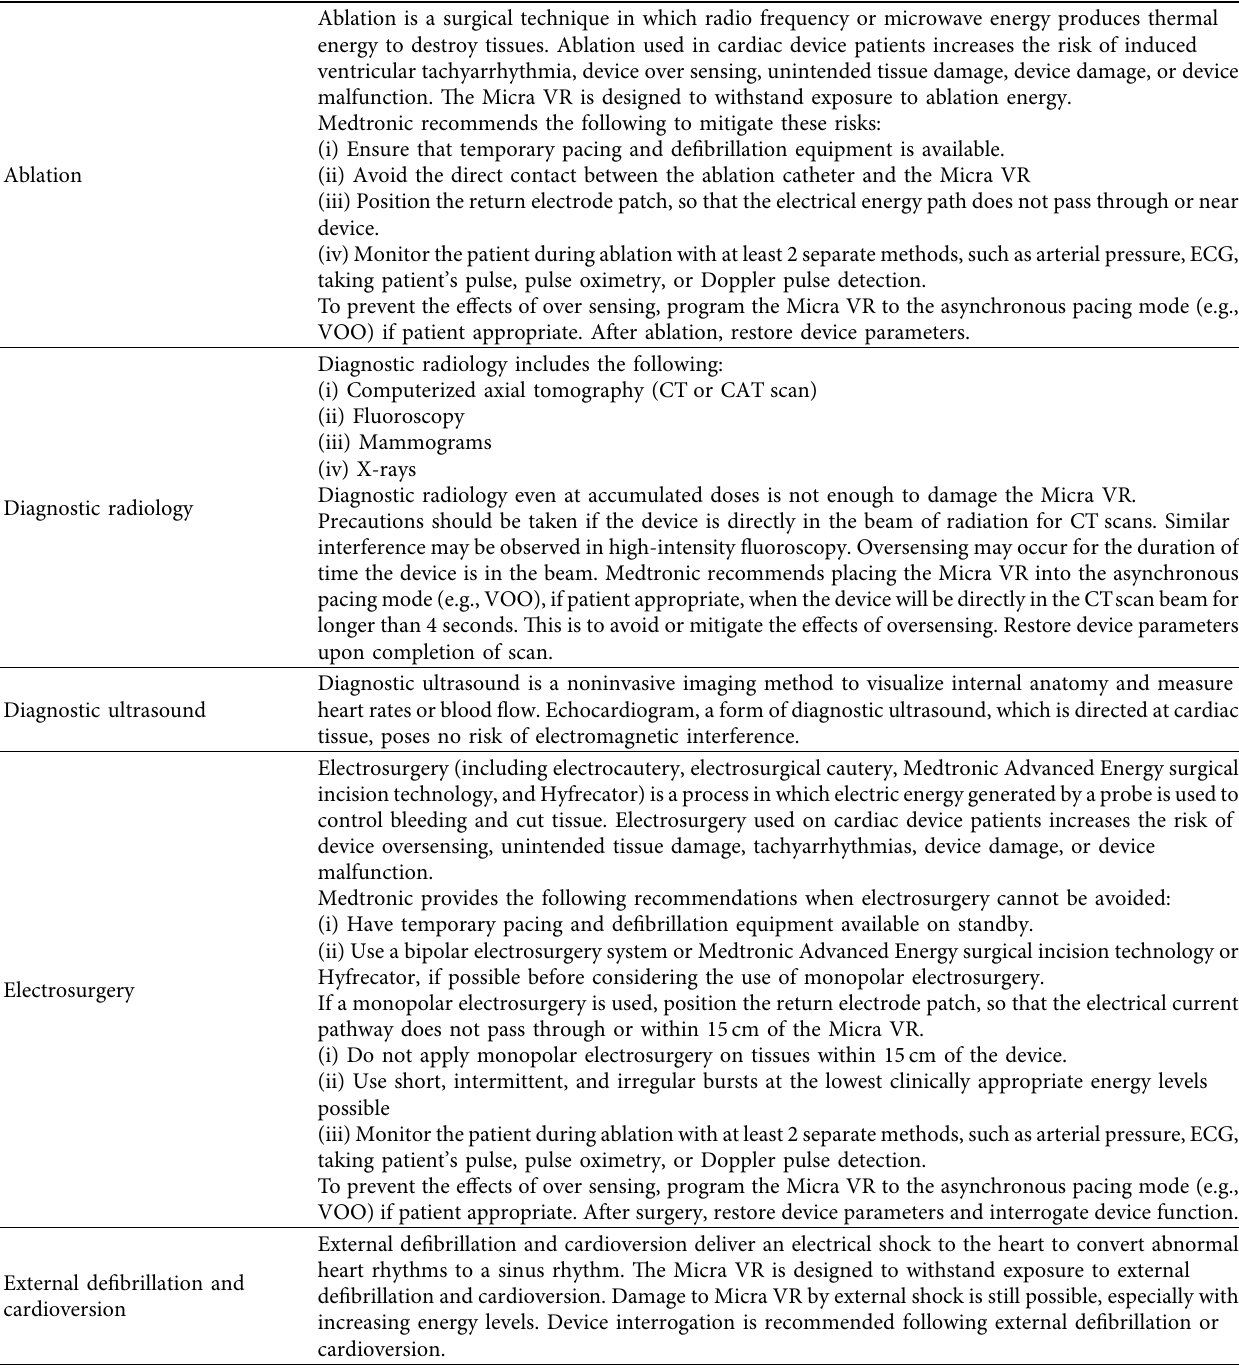
Table 1: Highlights of warnings, precautions, and guidance for clinicians performing medical procedures on cardiac device patients, modified from Medtronic manual for Micra